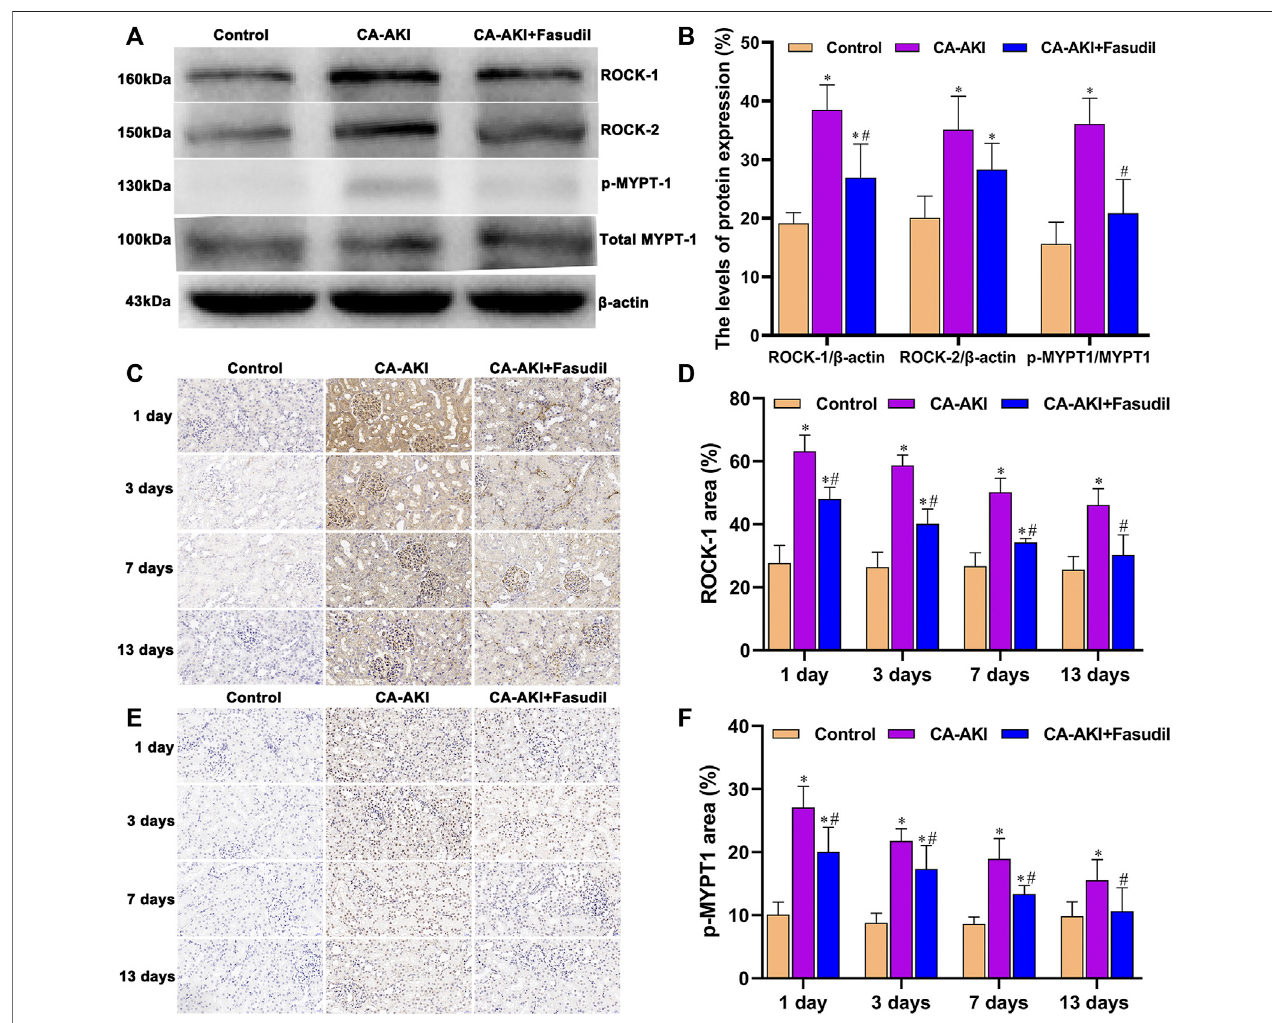
FIGURE 8 | Rho/ROCK expression in three animal groups: (A) expression levels of ROCK-1, ROCK-2, MYPT1, and p-MYPT1 by group (western blot); (B) relative densitometryanalysisofprotein ratios; (C) ROCK-1expressionbygroup; (D) ROCK-1scoresbygroup; (E) p-MYPT1 expressionbygroup; and (F) p-MYPT1scoresby group.* p < 0.05 between CA-AKI/CA-AKI + Fasudil and controls; # p < 0.05 between CA-AKI + Fasudil and CA-AKI.